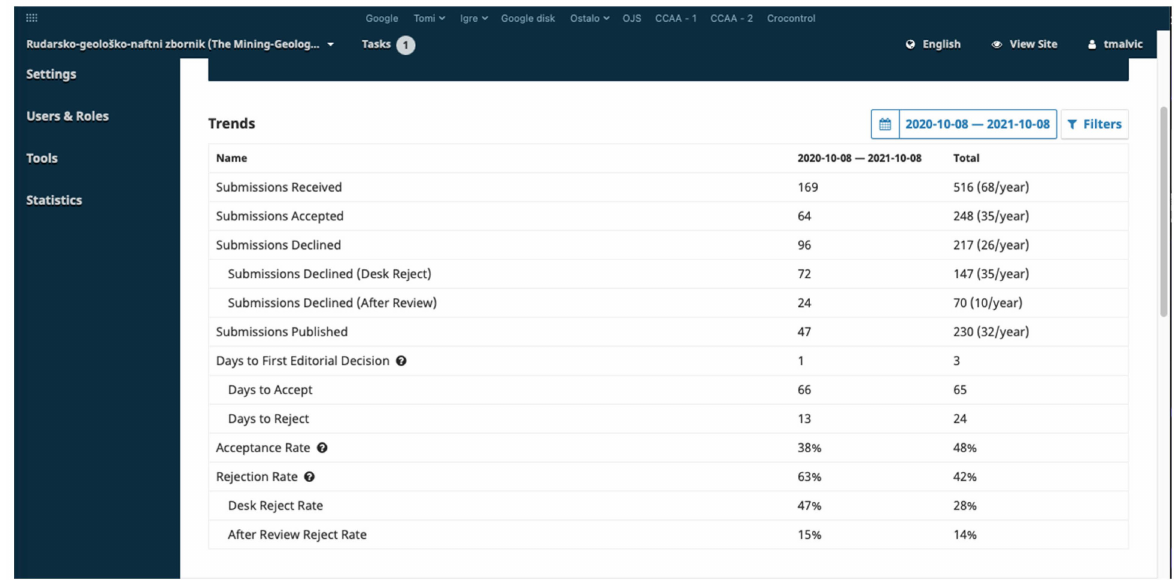
Figure 16. The rejection and acceptance rates (169 submissions, 96 rejected, 64 accepted) in the analysed journal (October 2020–October 2021); the total score of accepted vs. declined and its rates do not correspond to 100%, because the dataset also included active manuscripts in the OJS